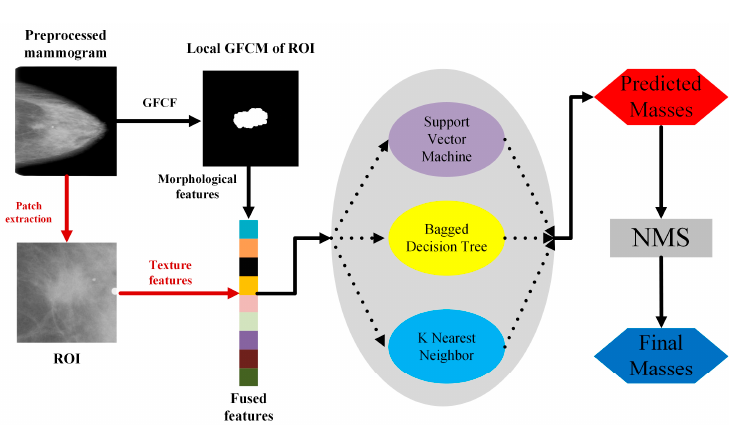
Figure 4. False positive reduction via machine-learning models .